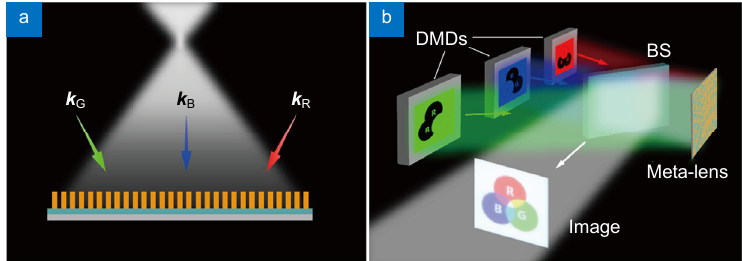
Fig. 1 | ( a ) Schematic of the off-axis multi-wavelength dispersion controlling metalens. The metasurface is illuminated by three lights with different wavelengths and incident angles, and then focuses the reflected lights into the same point. ( b ) Schematic of a 3-chips DMD laser projection sys- tem with the dispersion-engineered metalens. The three monochromatic (R, G and B) images can be synthesized into a color image after reflect- ed by the metasurface. BS: beam